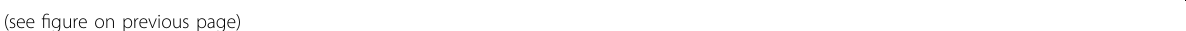
Fig. 4 TR-MRE11 co-localises less frequently than FL-MRE11with γ H2AX after IR in VM-CUB1 cells. A Western blot of established cell lines from VM-CUB1. Endogenous MRE11 was knocked down and replaced with either exogenous FL or TR-MRE11, and named MRE11 knockdown (KD), FL- MRE11, and TR-MRE11 cells, respectively. B Immuno fl uorescence microscopy of MRE11 and γ H2AX foci showing co-localisation and some failure of co-localisation after IR (2 Gy, 24 hr post-IR). MRE11 foci were clearly knocked down in the shMRE11 sample and rescued in FL and TR. C TR-MRE11 colocalises with γ H2AX less than FL-MRE11 does. Data are presented as means ± SEM ( P < 0.001 (***), P < 0.01 (**)). D Correlation between MRE11 and γ H2AX foci numbers from ( B ). MRE11 de fi cient and TR-MRE11 cells showed non-signi fi cantly lower slopes for γ H2AX foci compared to FL-MRE11 and untreated cells. E Representative graphs for propidium iodide cell cycle. F Cell cycle distribution of RT112 UT, KD, FL-MRE11, and TR-MRE11 cells was quantitatively analysed using fl ow cytometry (****<0.0001, **<0.01, * P < 0.05; one-way ANOVA, n = 3, mean +